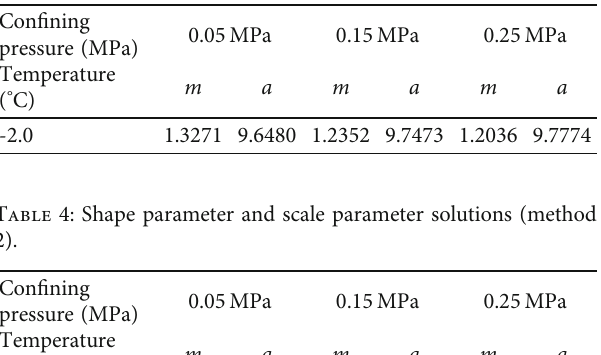
Table 3: Shape parameter and scale parameter solutions (method 1).